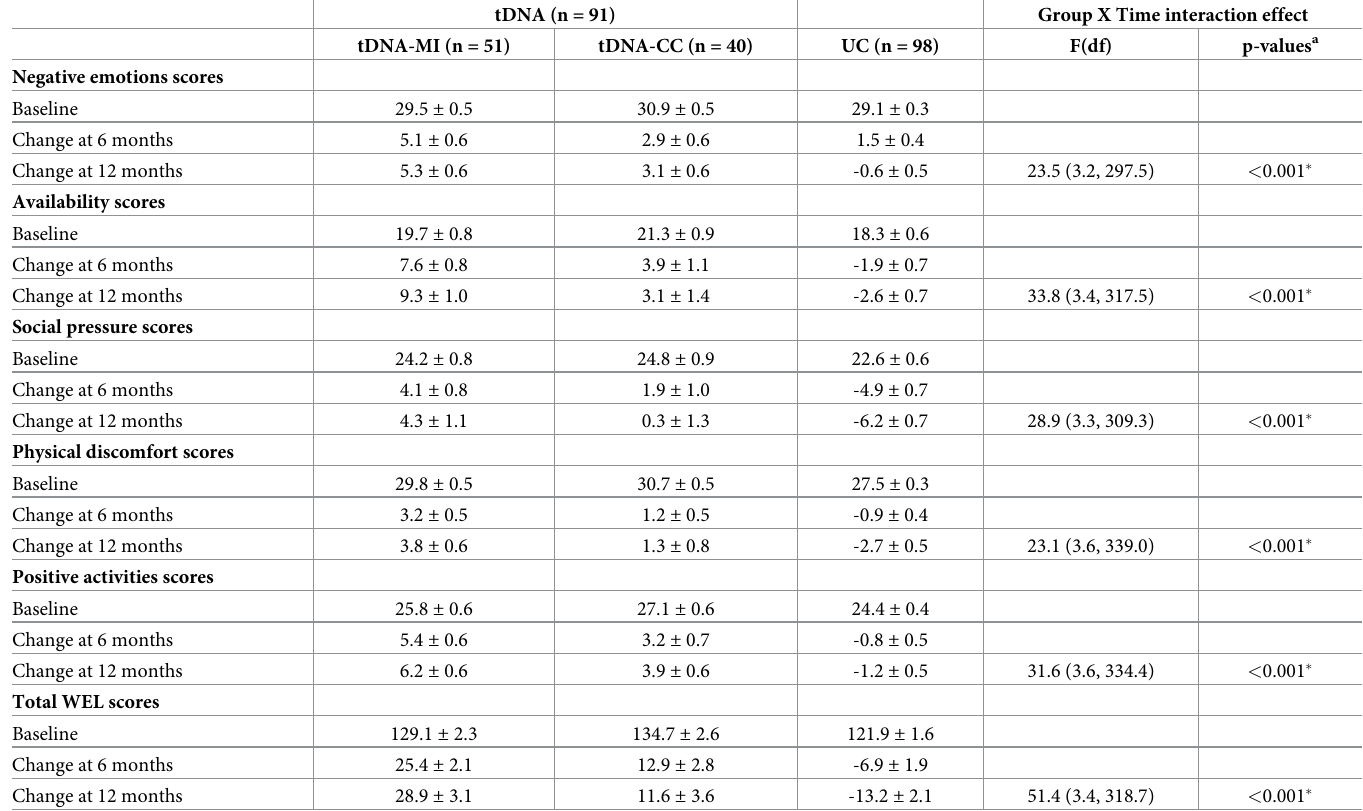
Table 3. Weight Efficacy Lifestyle (WEL) scores change overtime from baseline to 12 months of intervention (mean ± SE). tDNA (n =